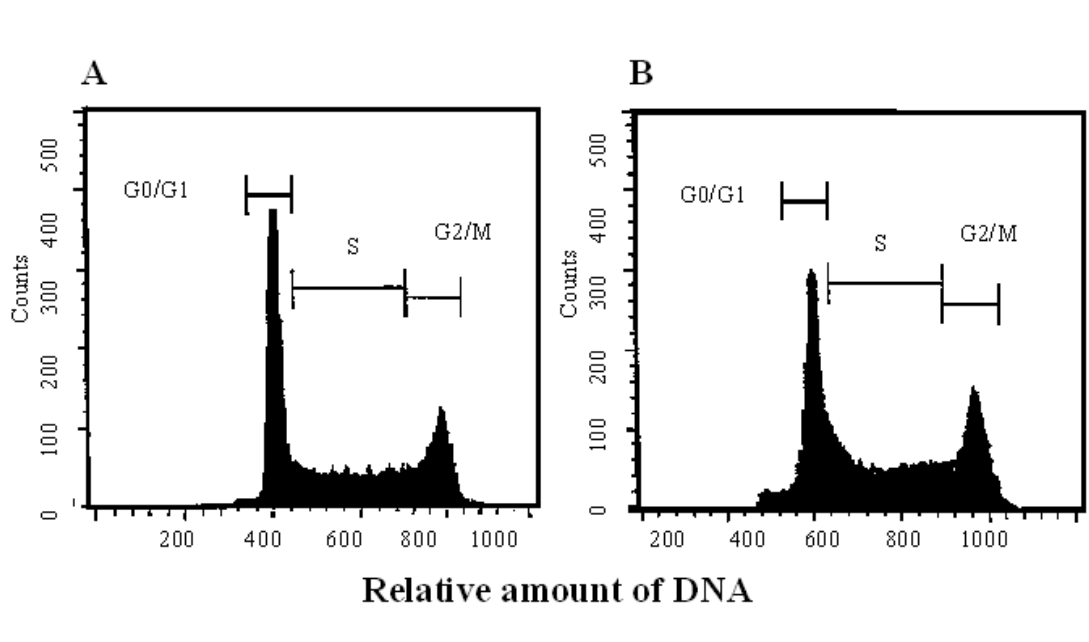
FIGURE 4 . Histograms of the cultivated cells without (A) or with IL-6 (B) treatment in human myeloma cell line RPMI-8226. The X-axis represents the relative amount of DNA, the y-axis the number of cells. The number of cells with the least DNA content is much greater in the G0/G1 phase than the number of cells with the highest DNA content in the phase G2/M.